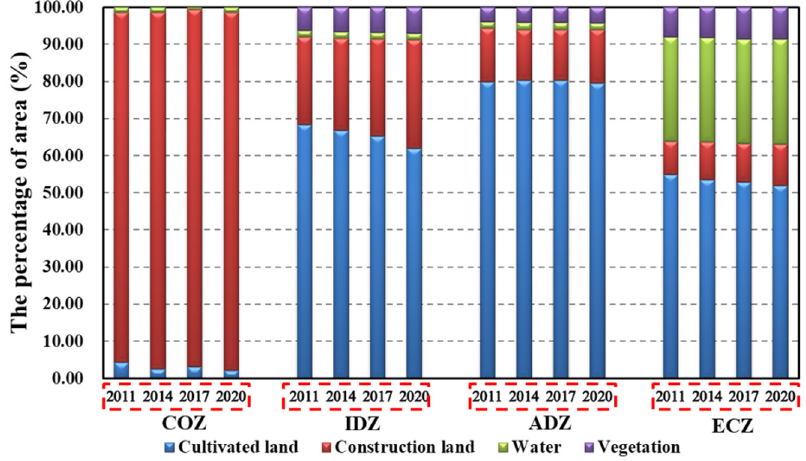
Figure 6. The area percentage of landscape types under MFOZ from 2011 to 2020.